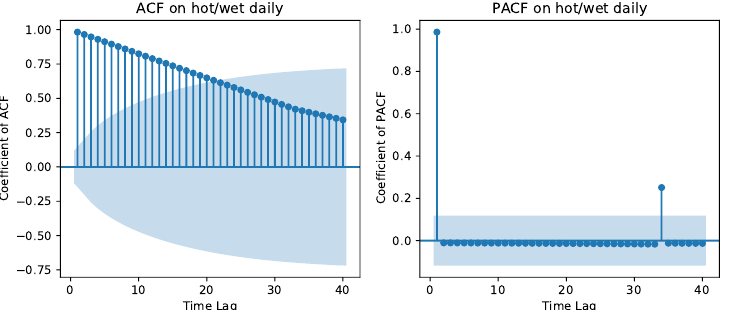
Figure 6. ACF (top-left panel) and PACF (top-right panel) on the cold/dry data showing non- stationarity. ACF (mid-left panel) and PACF (mid-right panel) on the hot/dry data showing non- stationarity. ACF (bottom-left panel) and PACF (bottom-right panel) on the hot/wet data showing non-stationarity on exogenous